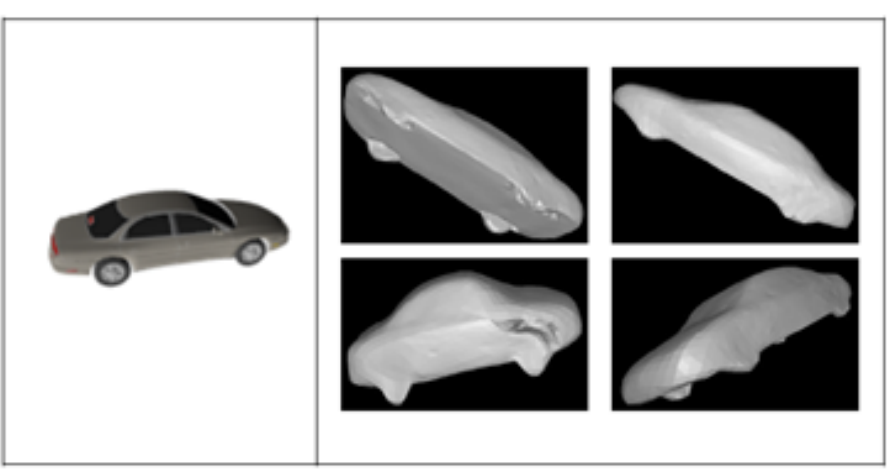
Figure 1. 2D image and its corresponding 3D